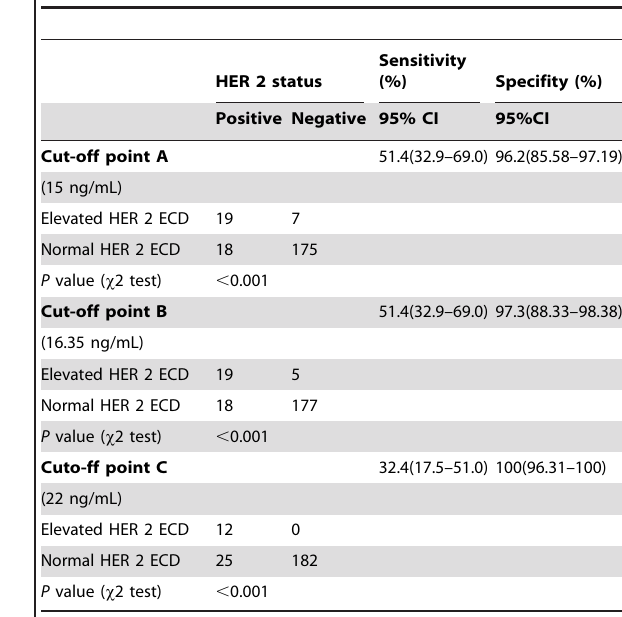
Table 1. Association between serum HER 2 ECD levels and tissue HER 2 status (with different cut-off